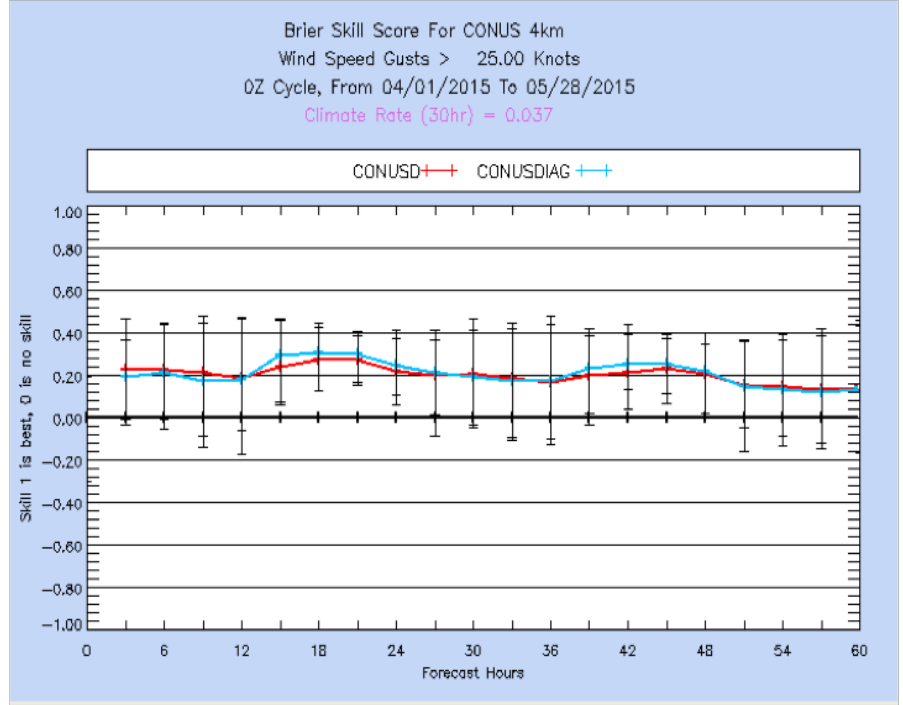
Figure 19. Brier skill score for 10-meter wind gusts exceeding 25 knots (12.9 m/s) for the period 1 Apr 2015 to 28 May 2015 for the operational (at that time) 4-km MEPS compared to 10-meter wind gust observations in the US (CONUSD; in red) versus the “Rolling” ensemble (CONUSDIAG; in blue). Error bars represent the 95% confidence interval for the skill score.